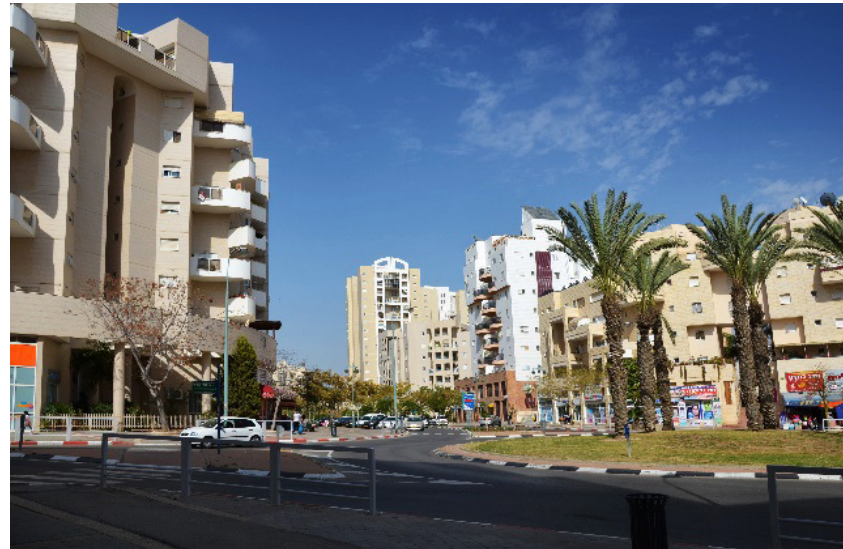
Figure 7. Mixed‐use main axis in Neve Zeev Neighborhood, Beersheba, by AMAB Architects (1990s). Each building was planned by a different architect.